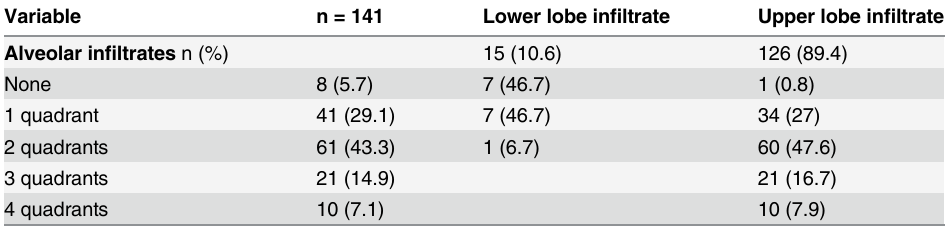
Table 3. Chest Radiograph (CXR) results according to the presence of alveolar infiltrates in the upper or lower lung